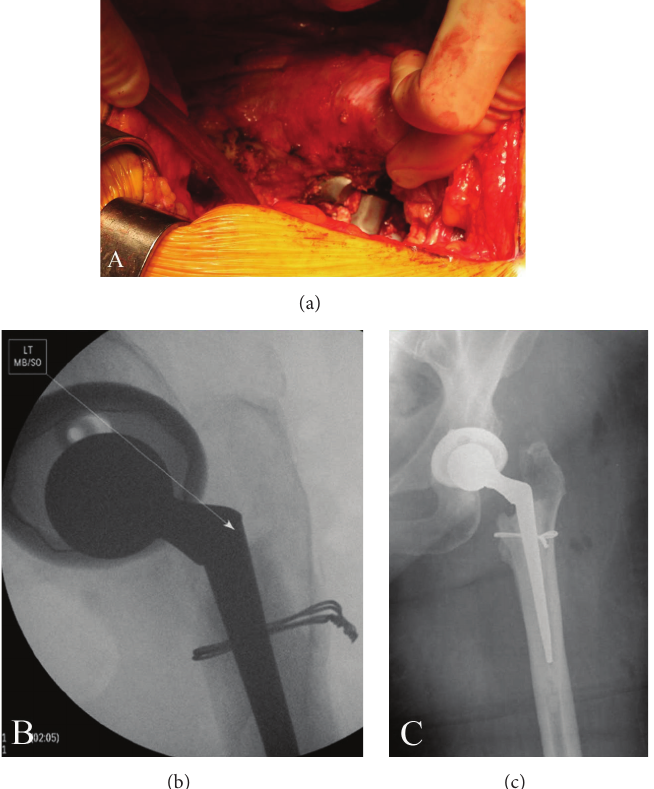
Figure 2: (a) Intraoperative femoral component fracture and separation. (b) A new locking ring and liner were placed in the preexisting well-fixed Duraloc cup. (c) Postoperative imaging confirms stable implant positioning.